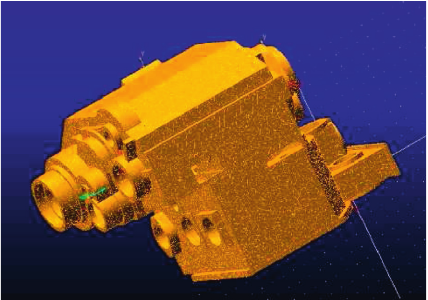
Figure 10: Housing model